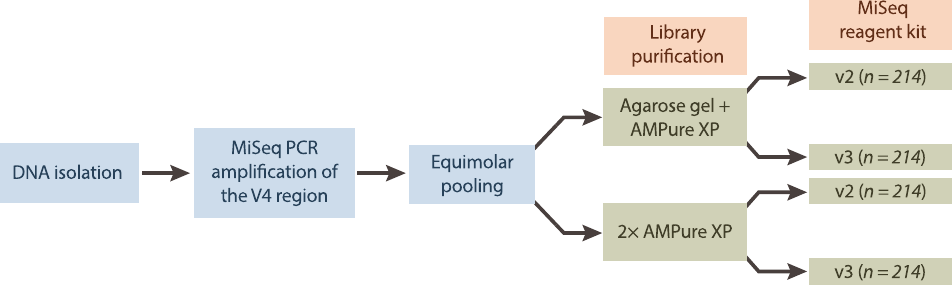
Figure 1. Flowchart of the laboratory procedures performed. Bacterial DNA was isolated, followed by PCR amplification using primers specific to the V4 region of the 16S-rRNA-gene, after which samples were pooled equimolarly. Library pools were then purified (gel-based or AMPure XP) and sequenced using MiSeq reagent kits (v2 or v3). We studied a set of 214 nasopharyngeal samples for each of the four combinations of library pool purification method and MiSeq reagent kits